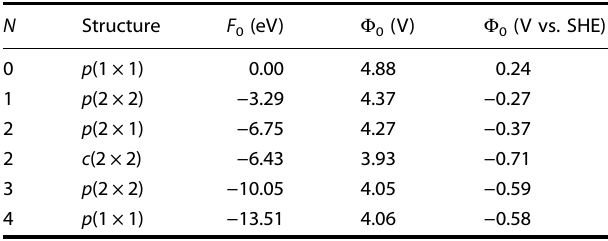
Table 2. Thermodynamic data obtained from the quantum – continuum calculations as a function of the number of adsorbed copper species